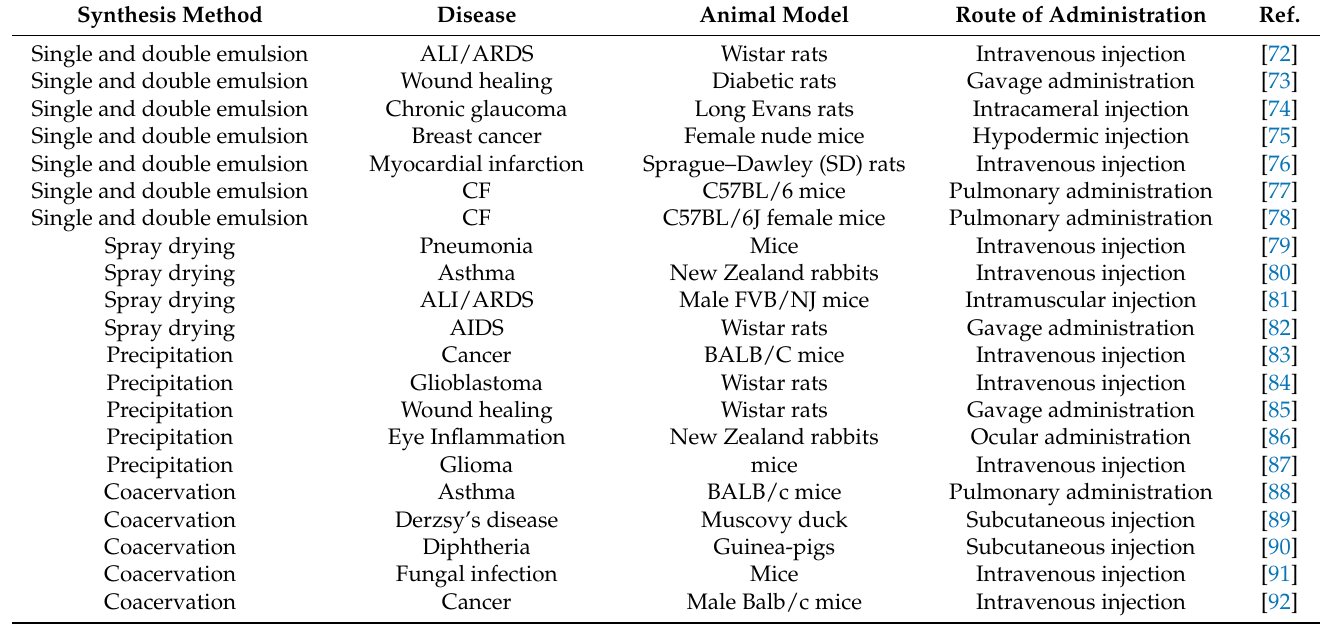
Table 1. Summary of the synthesis methods and